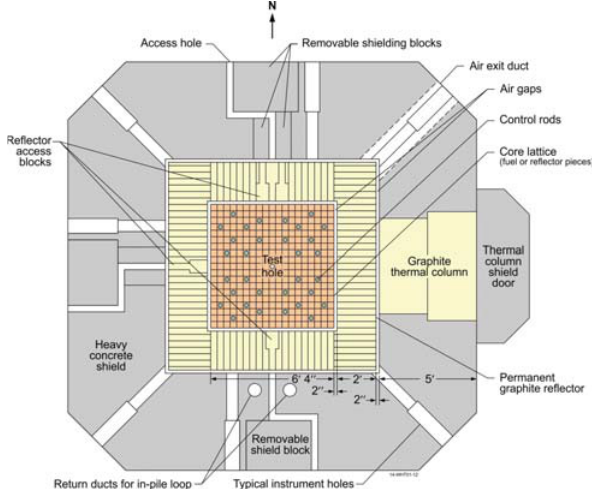
Figure 1: Top view of TREAT